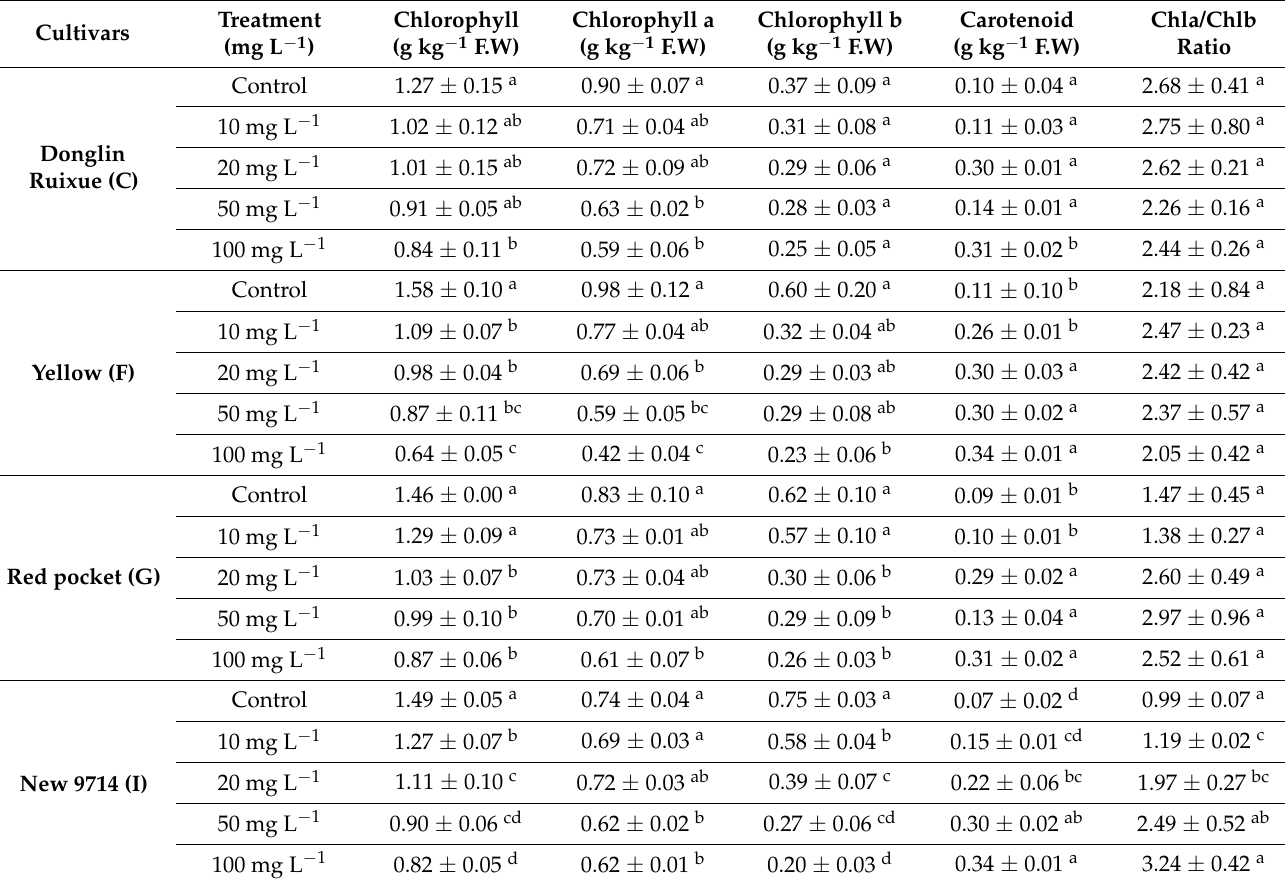
Table 2. Effect of Cd treatment on the chlorophyll, chlorophyll a, chlorophyll b, and